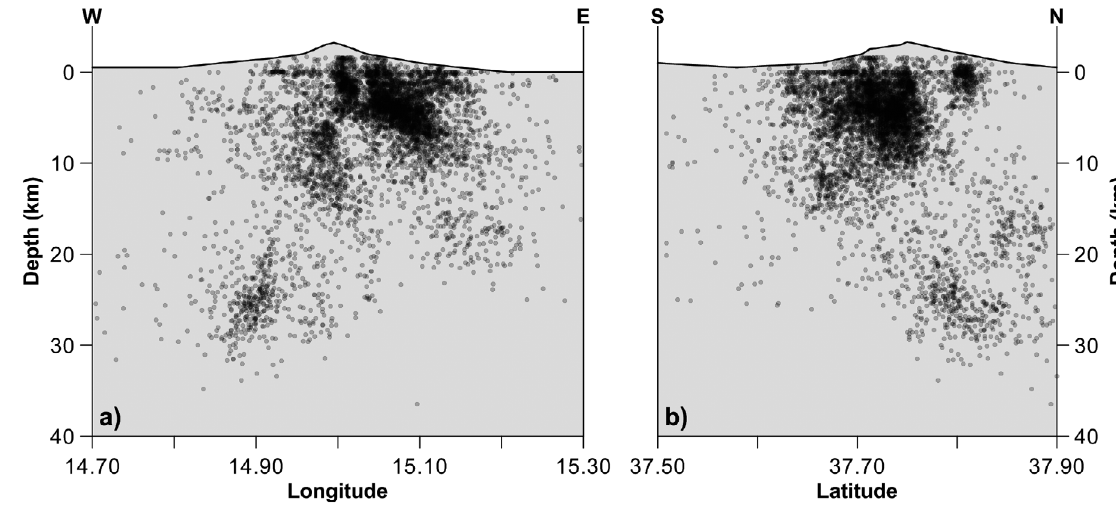
Figure 10. Cross-sections (E-W, Figure 10a; N-S, Figure 10b) of earthquakes showed in Figure 9.